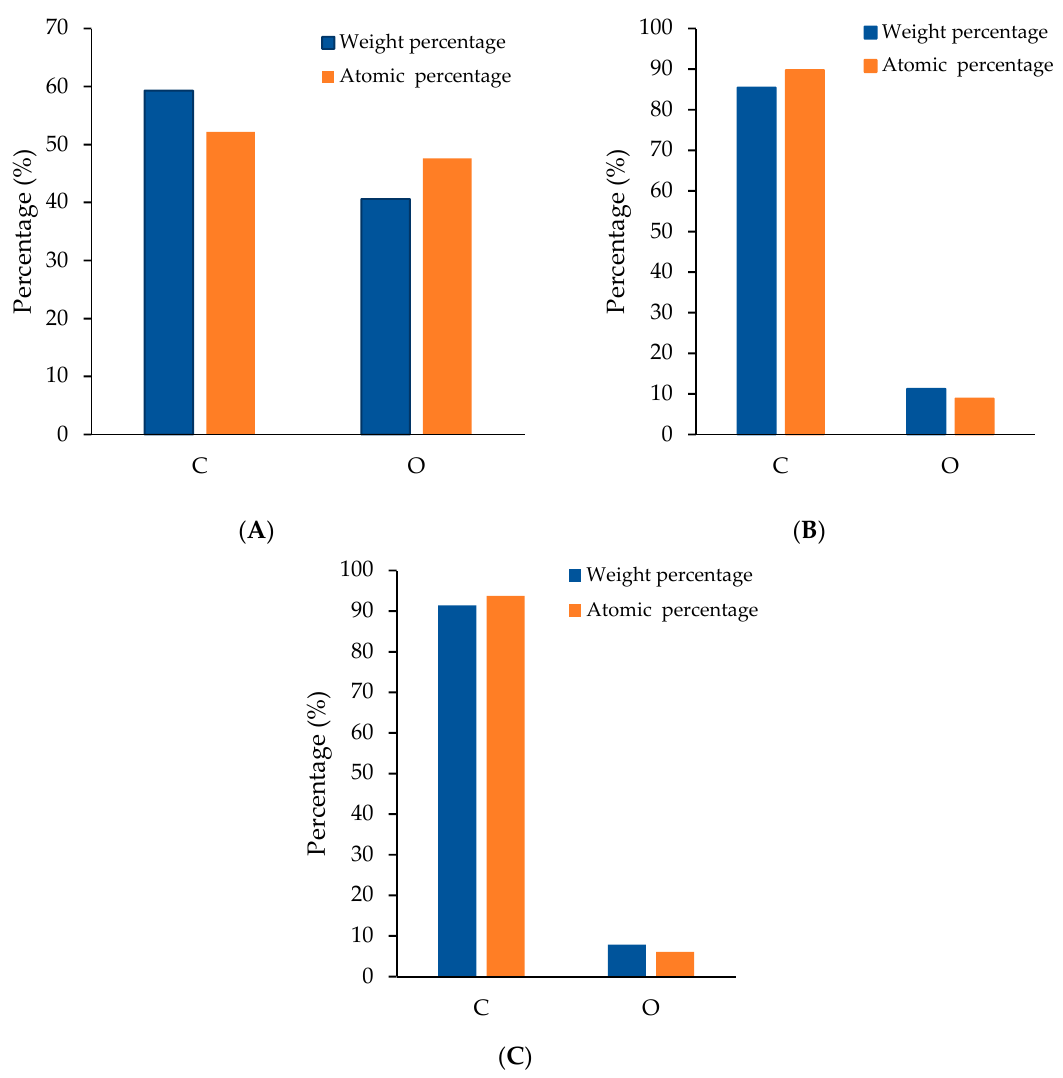
Figure 6. Weight and atomic elements percentage of raw macadamia nut shell ( A ) and MBC prepared at 900 °C ( B ) and 1000 °C ( C ); Na and Ca are detected in small amounts (0.2 and 0.001) in raw material but not at all at 900 °C and 1000 °C.